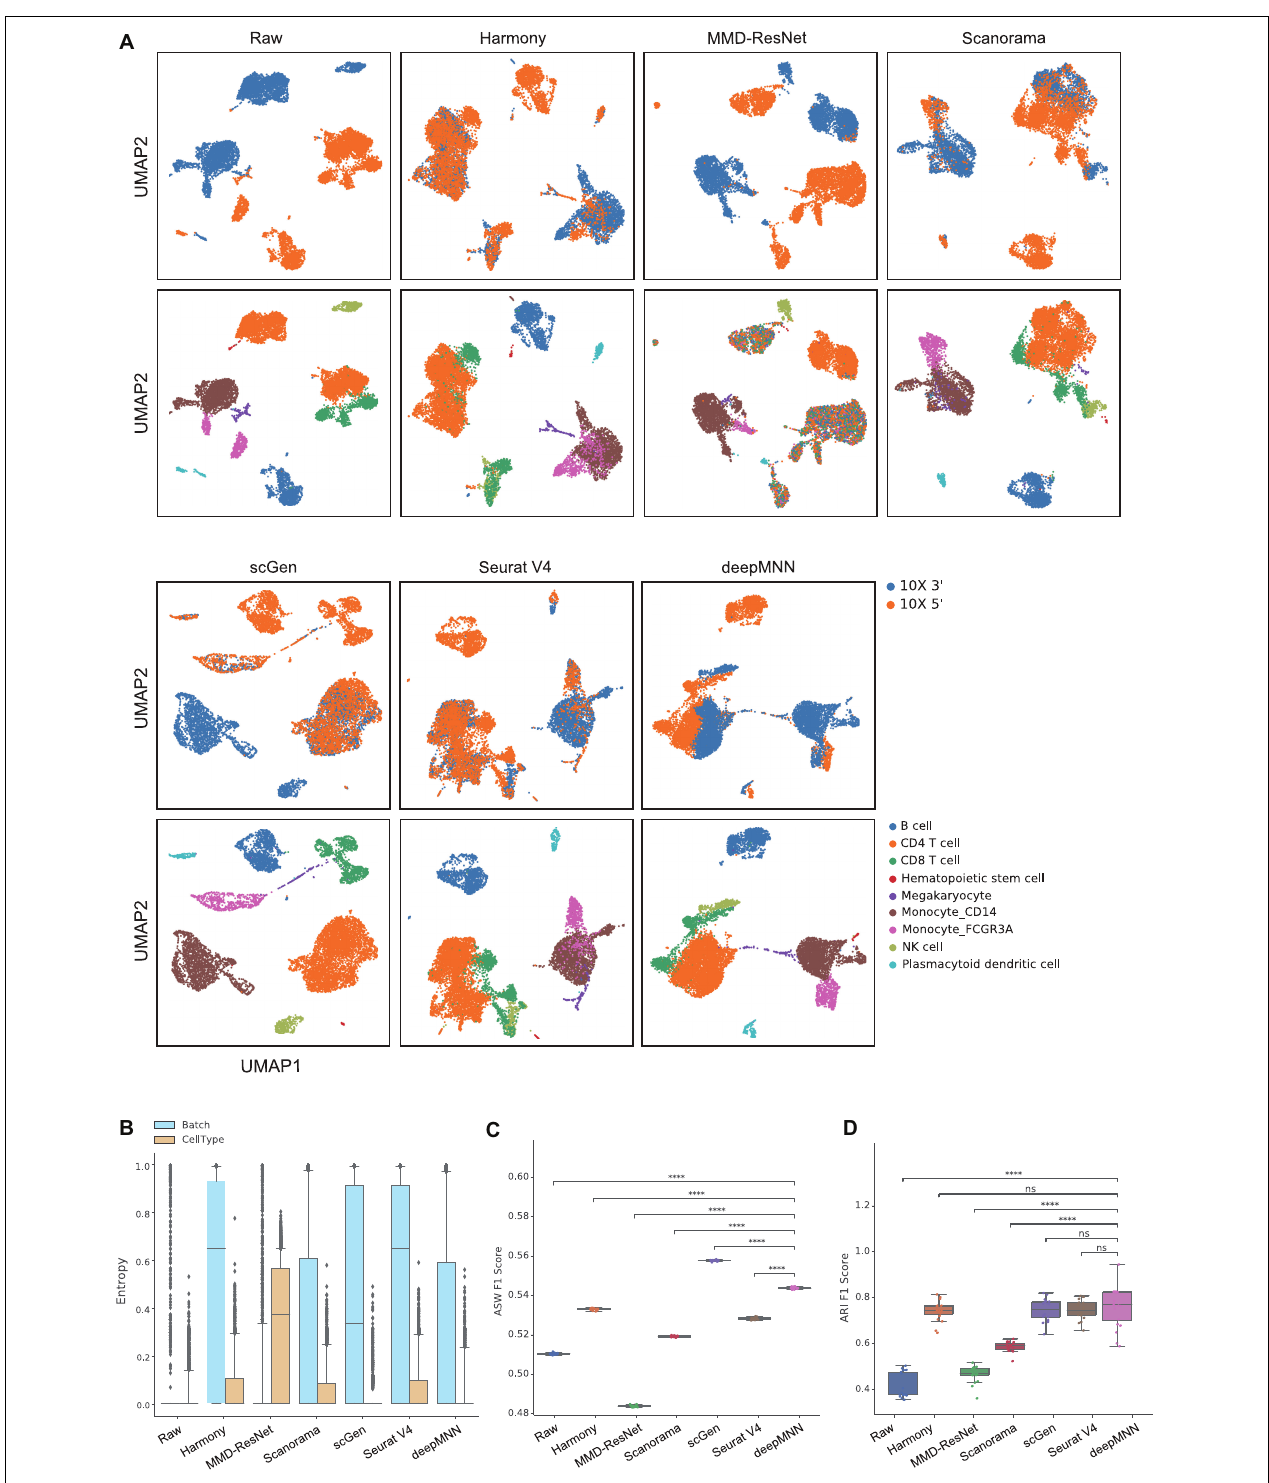
FIGURE 4 | Comparison of batch effect correction methods for the human peripheral blood mononuclear cell dataset of non-identical cell types with two batches. (A) Qualitative evaluation of the raw data, Harmony, MMD-ResNet, Scanorama, scGen, Seurat V4, and deepMNN using UMAP. The cells were colored by batches on the top row and colored by cell type on the bottom row. (B) The batch and cell type entropies resulting from the batch correction methods. The plots show the median (line within box), 25th and 75th percentiles (box), 5th and 95th percentiles (whiskers), and outliers (diamond points). (C) The ASW F1 score resulting from different batch correction methods. (D) The ARI F1 scores resulting from different batch correction methods. ∗∗∗∗ p ≤ 0.0001.